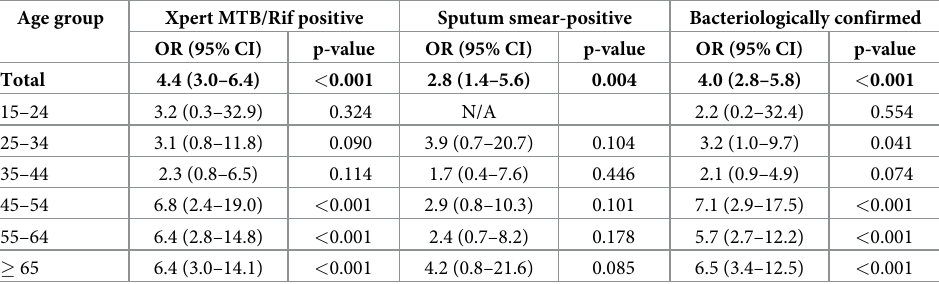
Table 6. Odds ratio of TB for men compared to women by age